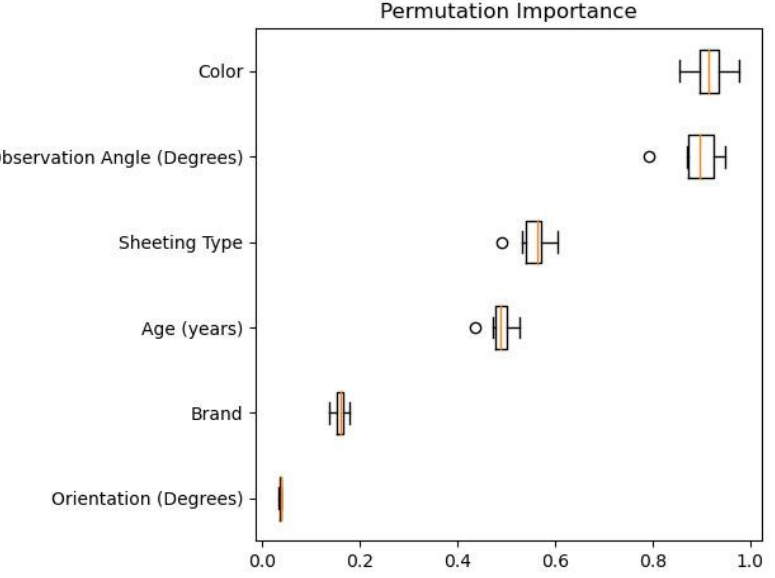
Figure 6. The result from running the permutation feature importance test on the dataset.